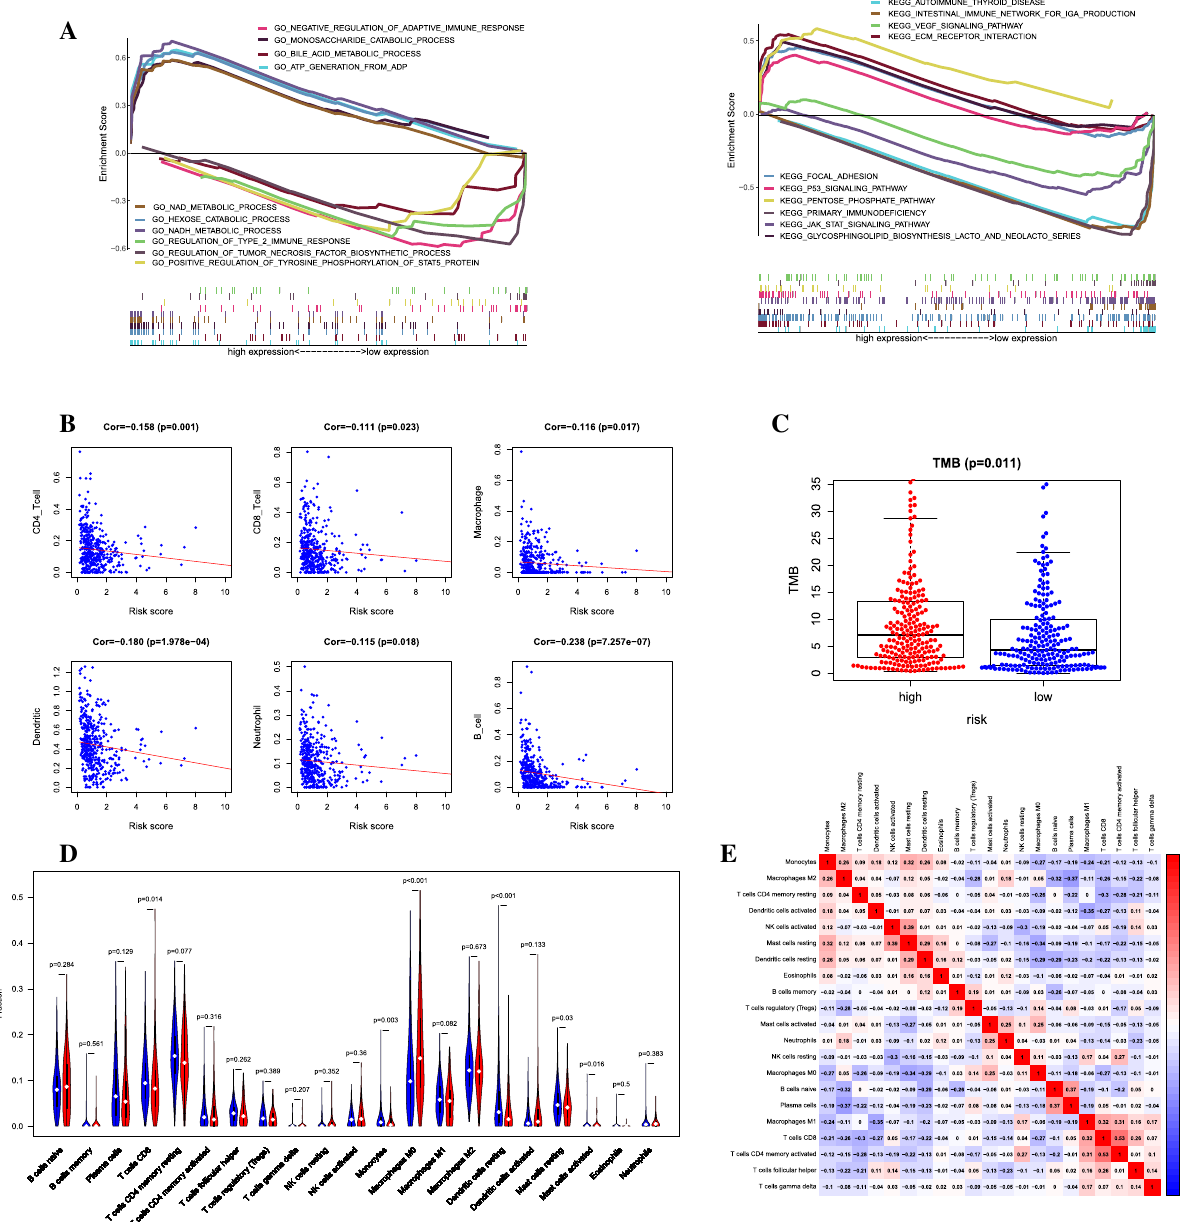
Figure 5. Gene Set Enrichment Analysis and Immune infiltration analysis. ( A ) GO term and KEGG pathway showed five positive correlation groups and five negative correlation groups, respectively. ( B ) TIMER indicated the correlations among the six immune cells and signature. ( C ) Difference analysis of TMB in high-risk and low- risk groups. ( D ) Composition of 21 kinds of immune cells in high-risk and low-risk groups. ( E ) Correlation heat map of 21 immune cells in